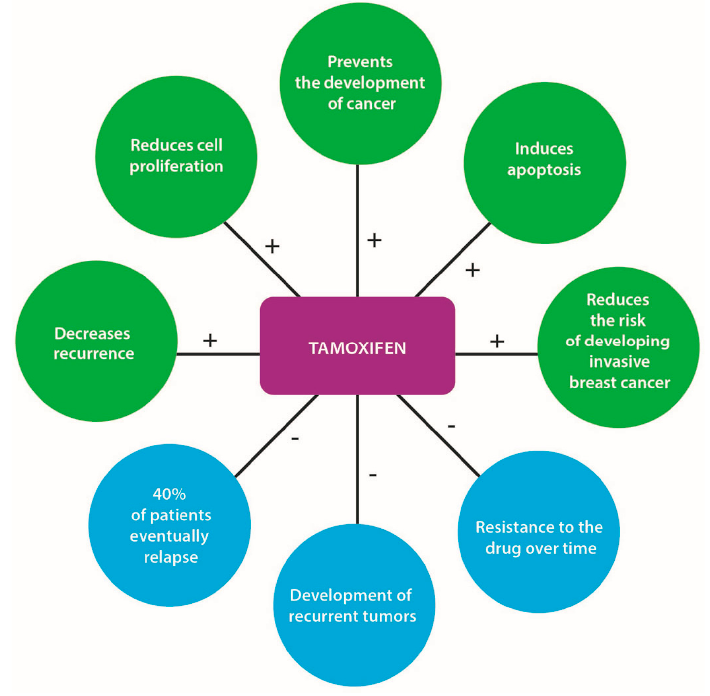
Figure 3. Tamoxifen’s positive and negative effects. Positive effects are indicated by a plus sign (+) and negative effects by a minus sign ( − ).